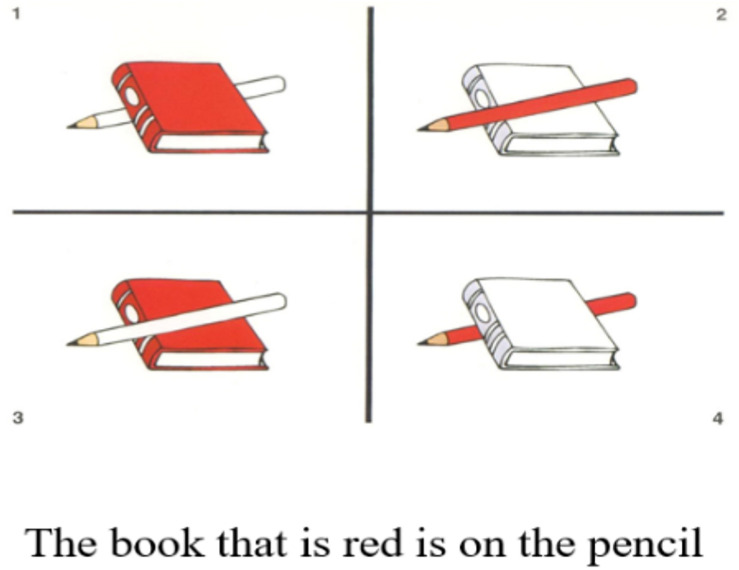
Example of a picture-sentence matching task targeting a relative clause, TROG- 2 (Bishop, 2003).